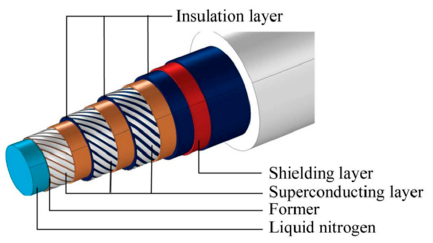
Figure 1. Schematic diagram of the structure of the tri-axial cable conductor.